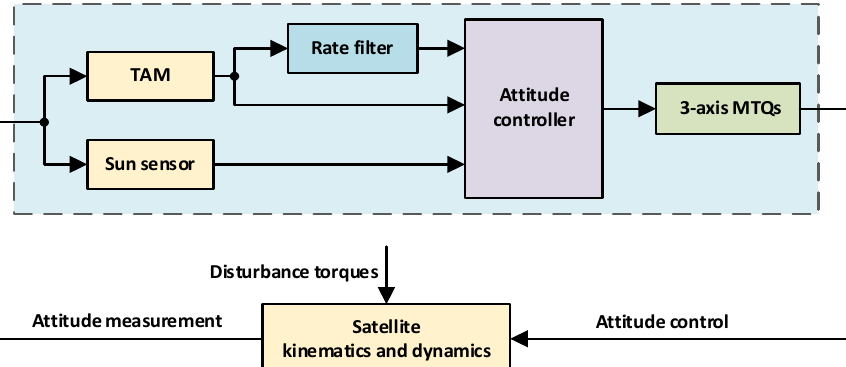
Figure 2. Sketch of the sun-oriented spin-stabilized attitude control method.